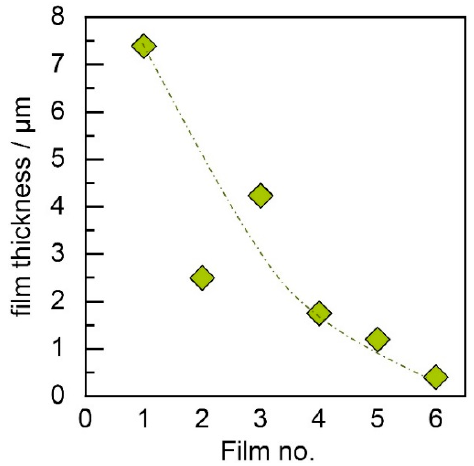
Figure 3. Development of film thickness over deposition time for the fluidized bed generator; the dotted line serves as guide for the eye.